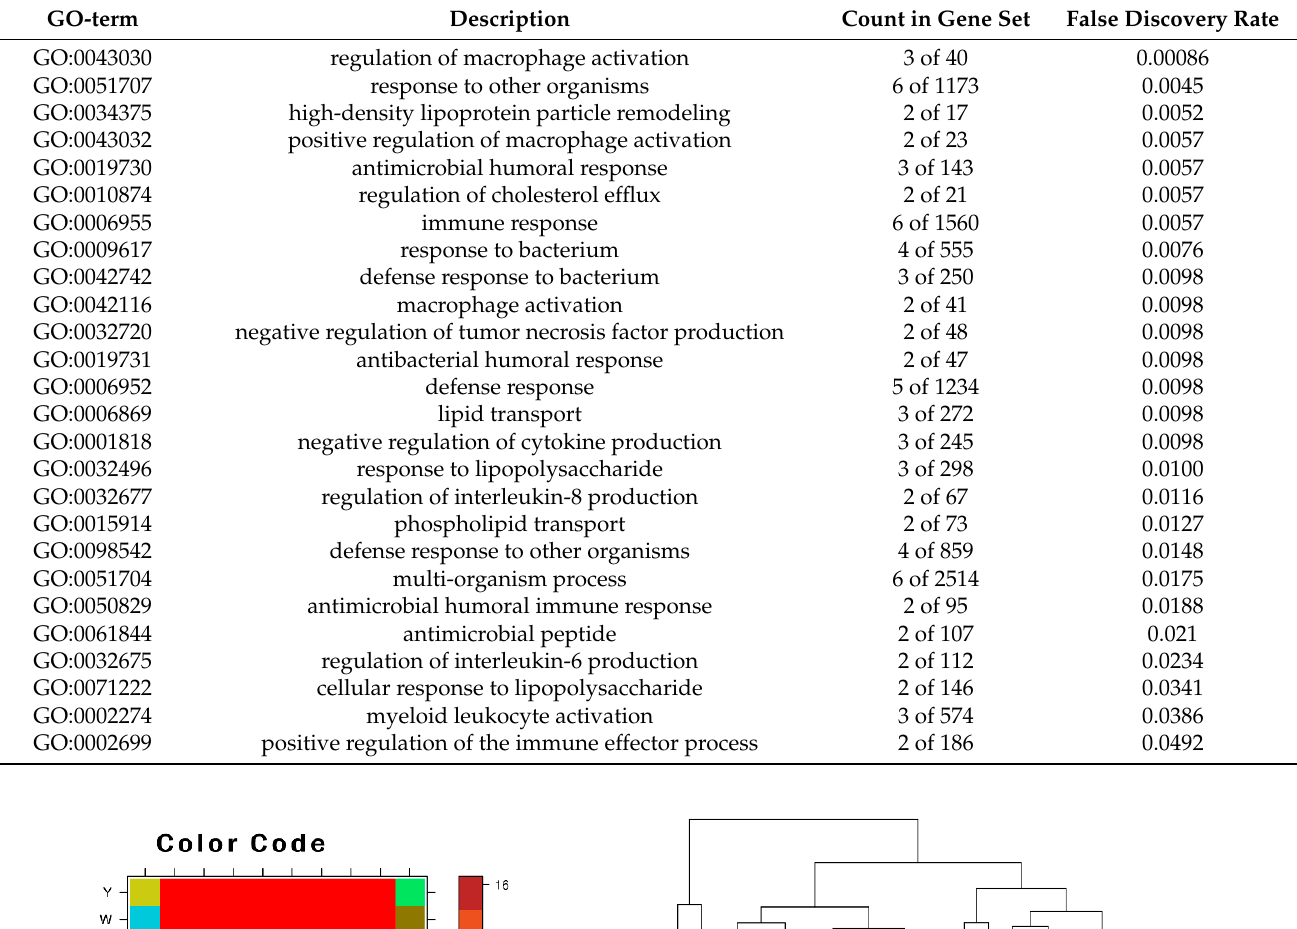
Table 6. Functional enrichment of biological processes in the human BPIFA1 protein network.